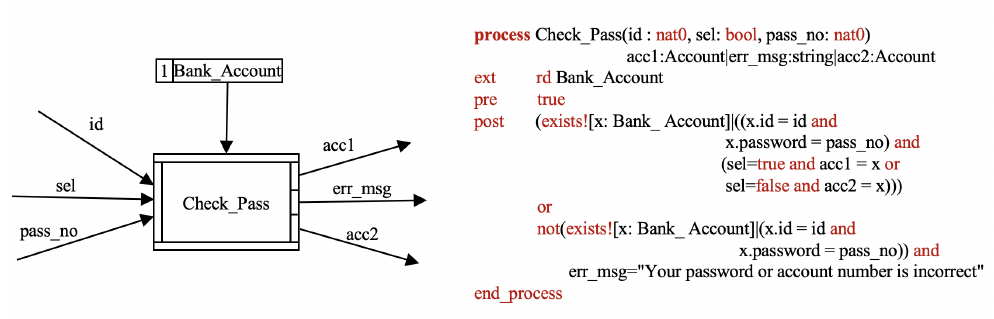
Figure 3. A process for checking